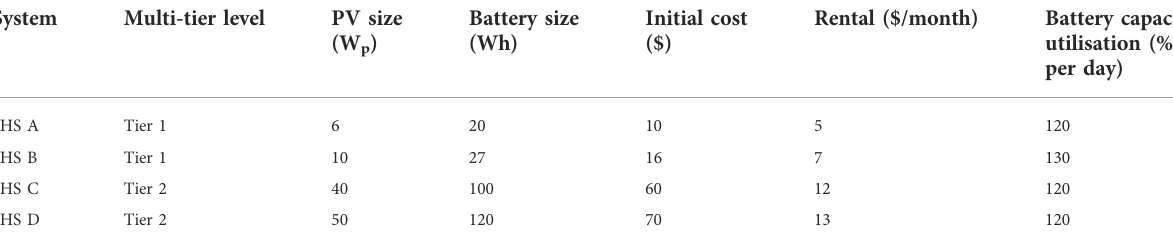
TABLE 2 Speci fi cations for various SHS con fi